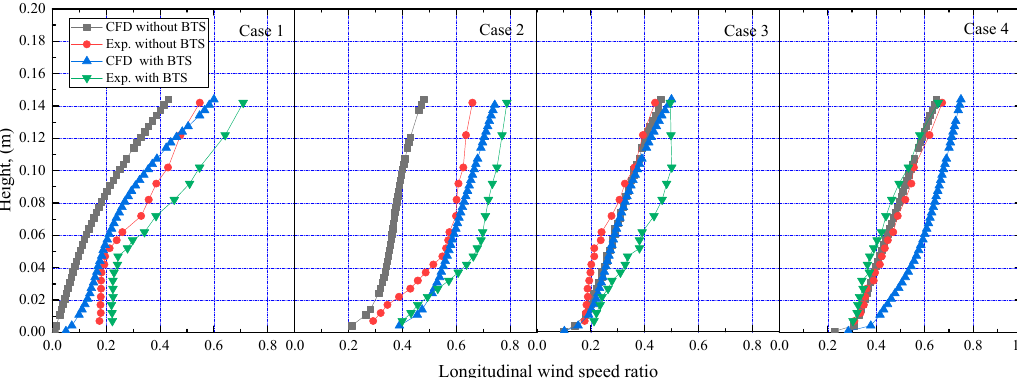
Figure 18. Numerical and experimental results of longitudinal wind speed ratio profiles at L/2.